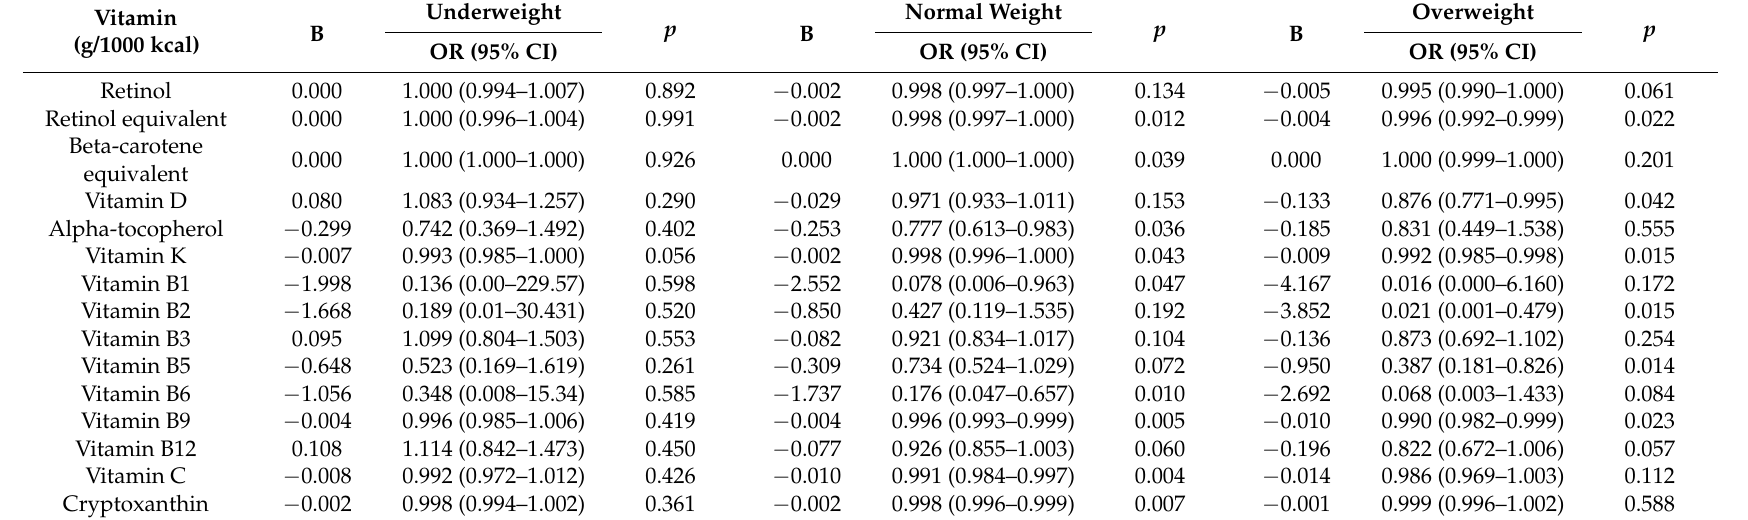
Table 6. Odds ratios (95% CI) for depressive symptom outcomes according to vitamin intake stratified by BMI in females